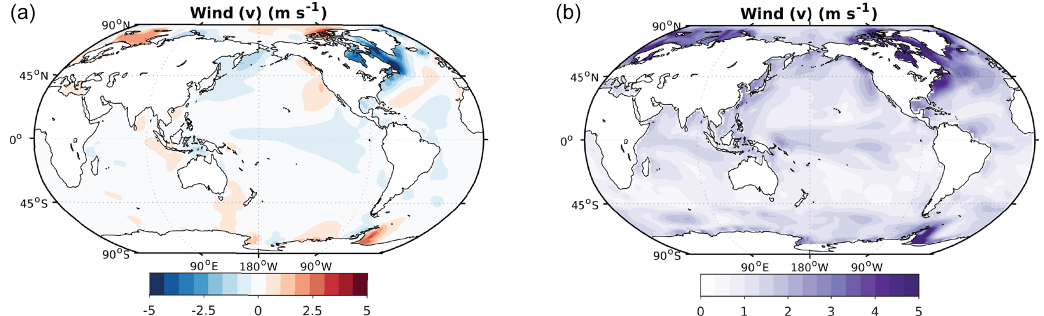
Figure 5. Annual mean meridional wind velocity lgm–piControl anomaly (a) and model spread (b) (in ms − 1 ).